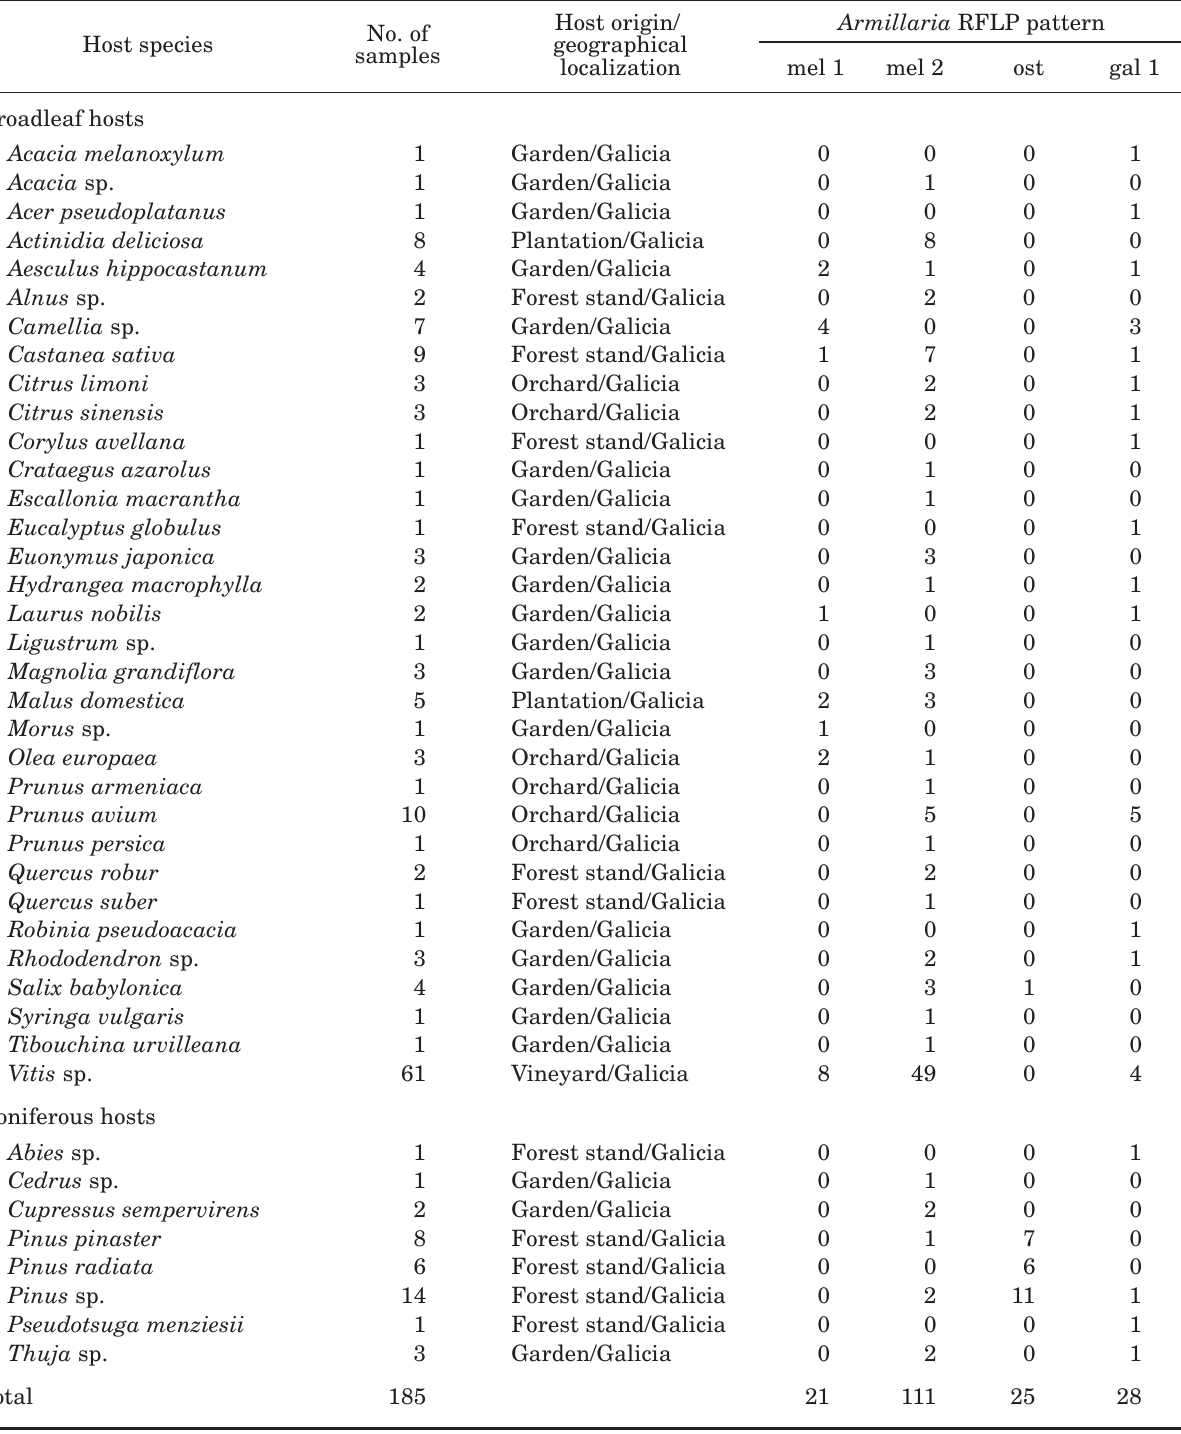
Table 1. Host species, number of samples, host origin, geographical localization and identification of Armillaria species according to RFLP